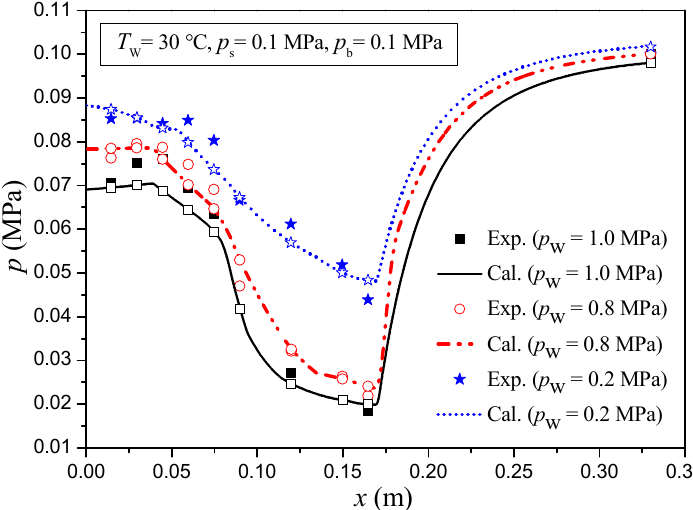
Energies 2022 , 15 , x FOR PEER REVIEW Figure 8. Pressure comparisons for different inlet steam pressures. Figure 8. Pressure comparisons for different inlet steam pressures.